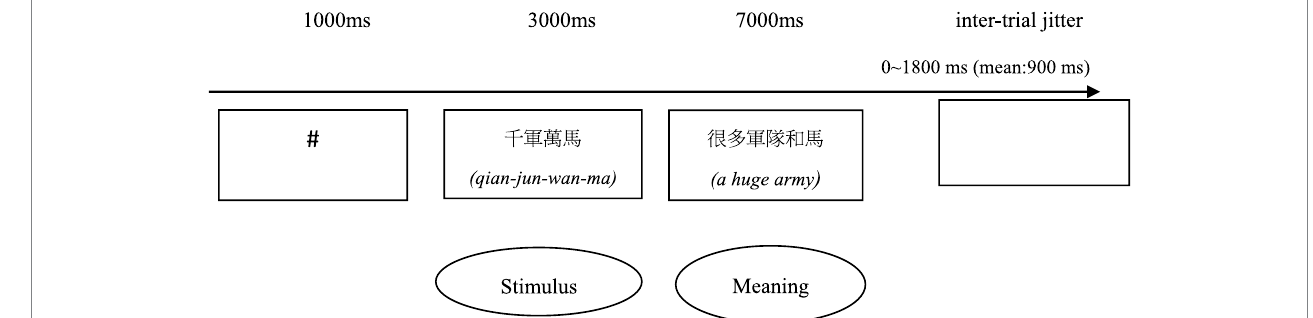
FIGURE 2 Illustration of the experimental